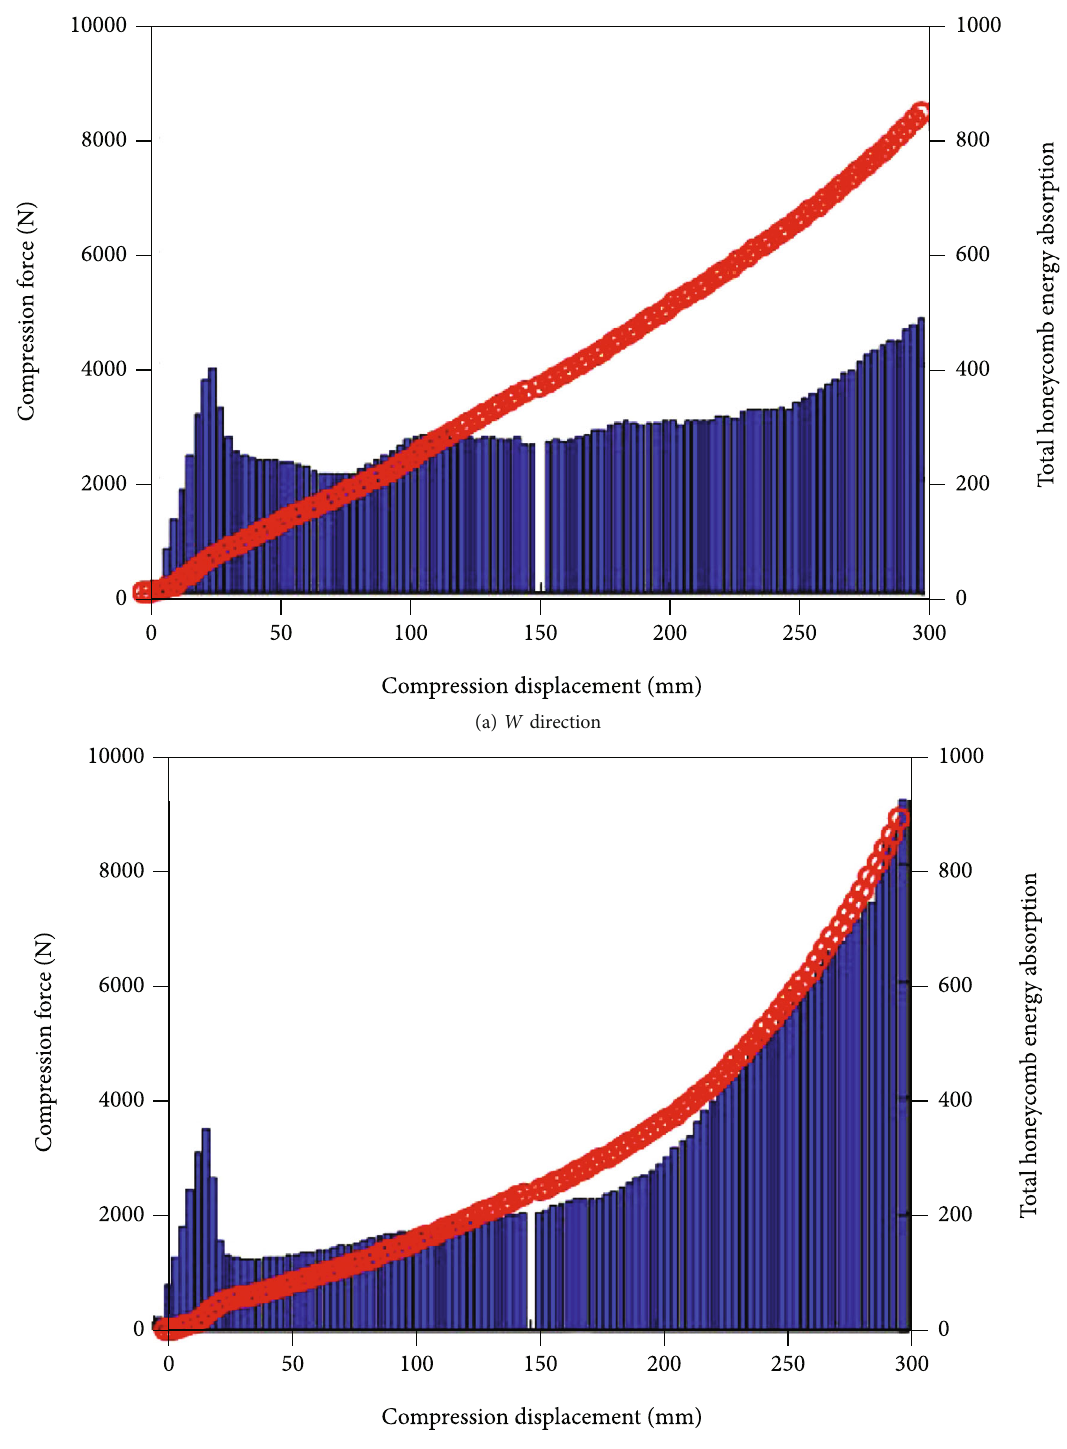
Figure 16: Honeycomb energy absorption curve under coplanar